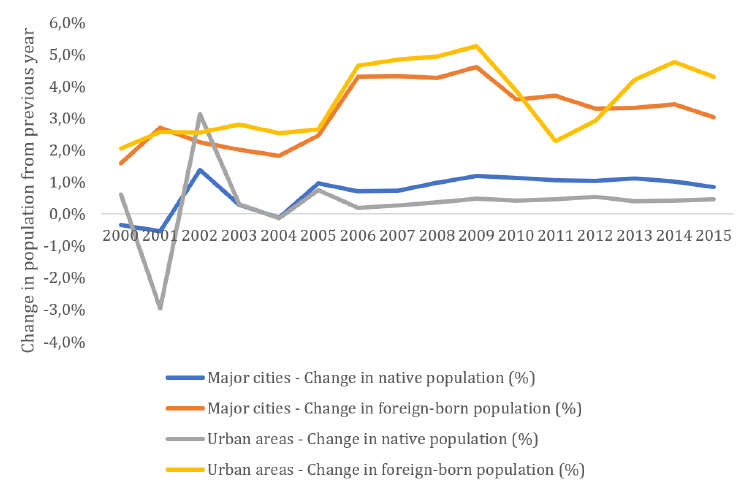
Figure 2: Change in population in different areas over